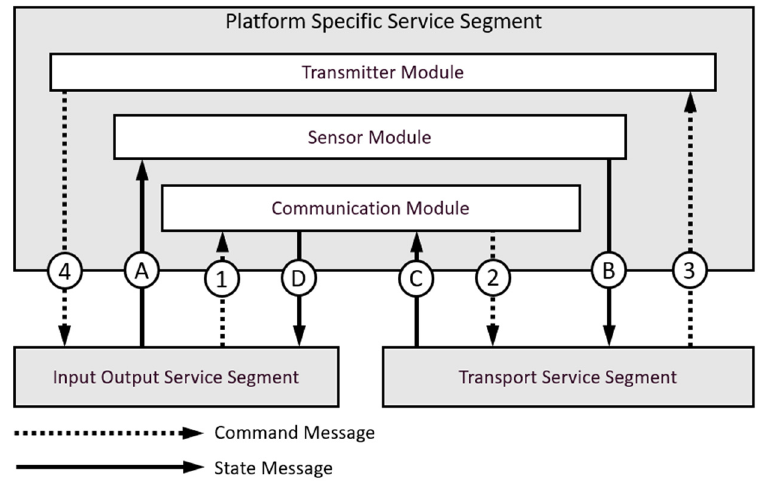
Figure 7. Data flow in the PSSS.